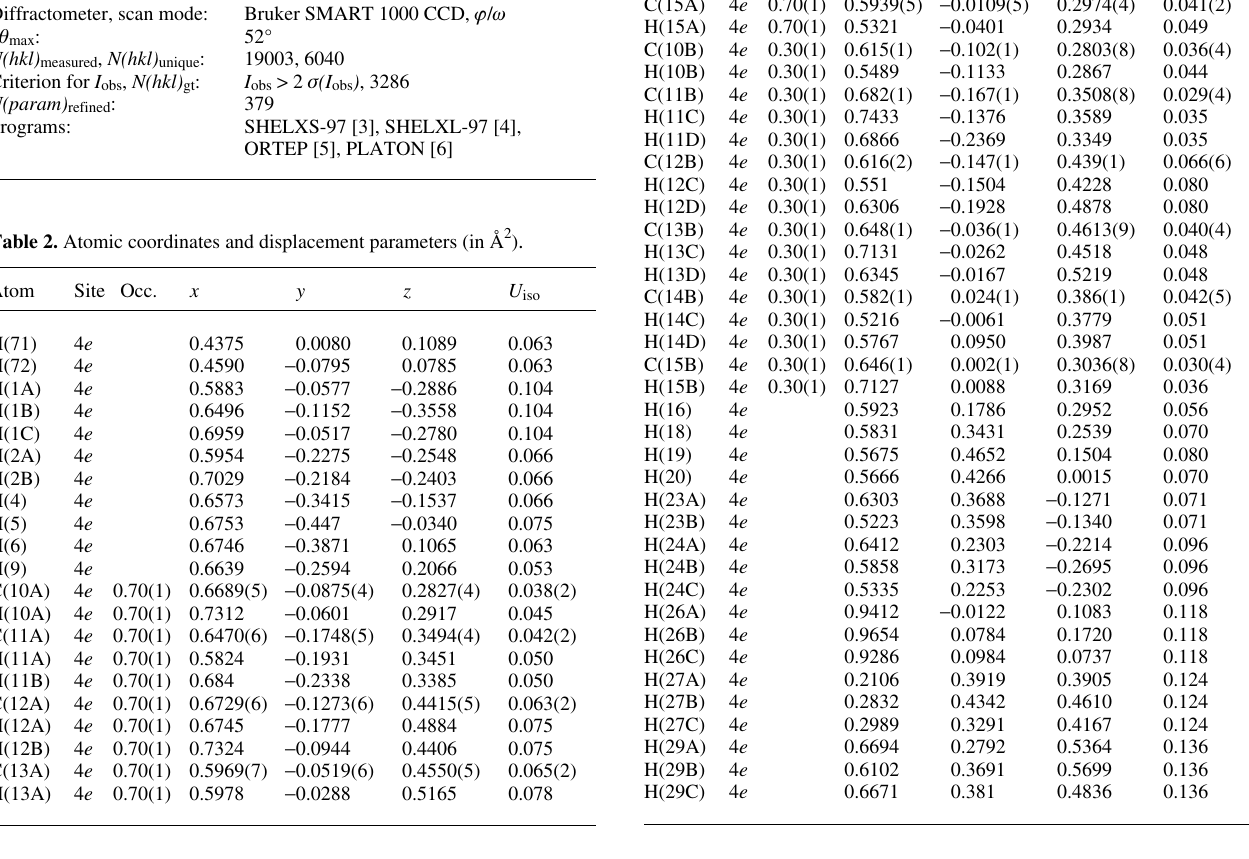
Table 3. Atomic coordinates and displacement parameters (in Å 2 ) .